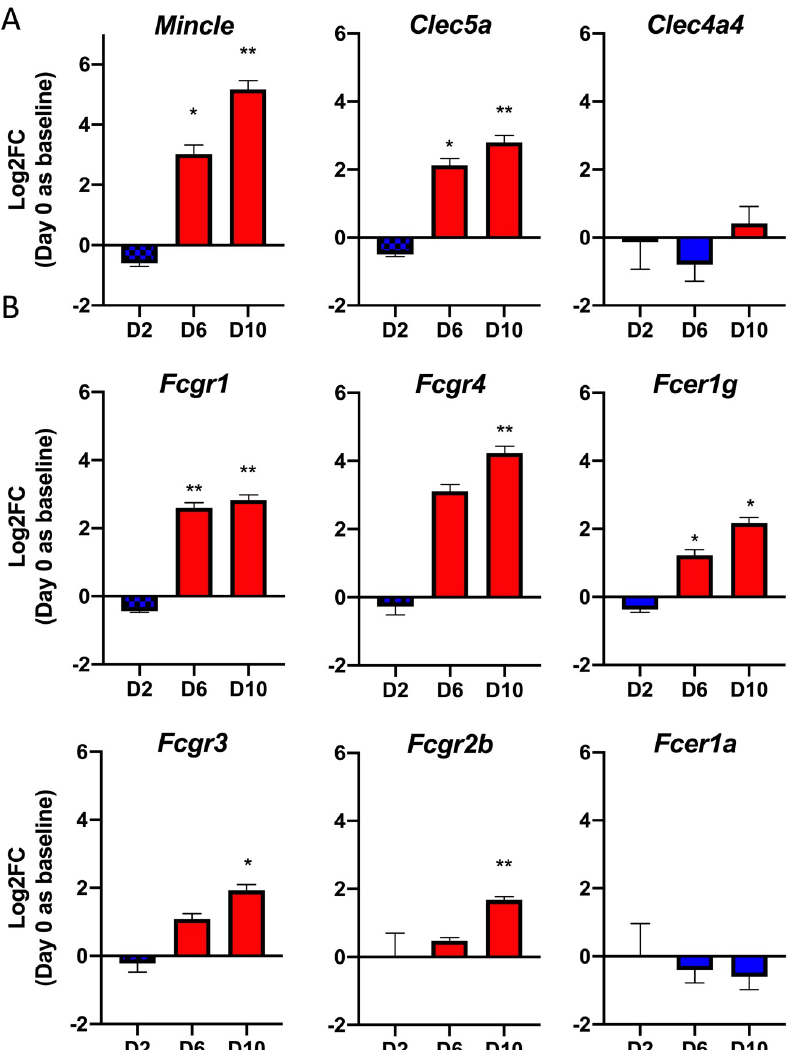
Fig 2. Differentially expressed CLRs and signaling partners. Nanostring gene profiling analysis was performed on lung tissue homogenates of mock and lethally infected mice, as in Fig 1. Kinetic expression data in Log2Fold change compared to the mocks for (A) indicated CLRs and (B) CLR signaling partners. Graphs are shown as mean ± SEM. Adjusted significance values for (A) and (B) were determined utilizing the Benjamini-Yekutieli test. � , p < 0.05; �� , p <